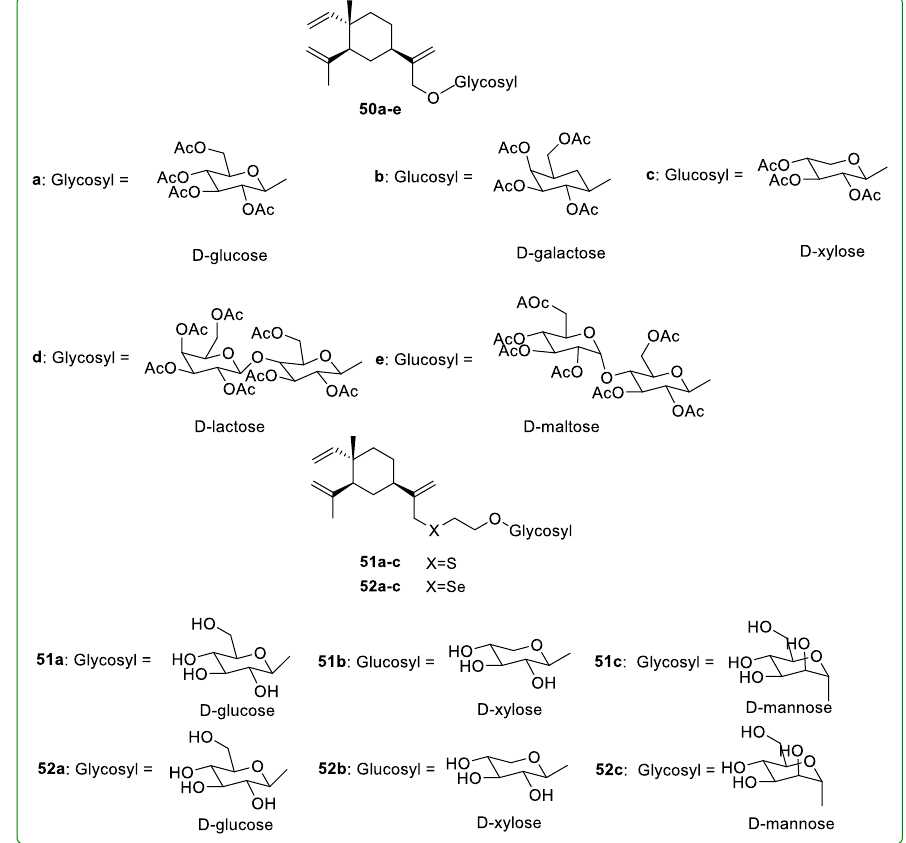
Figure 18. Chemical structures of β -elemene glycosylated derivatives 50 – 52 .